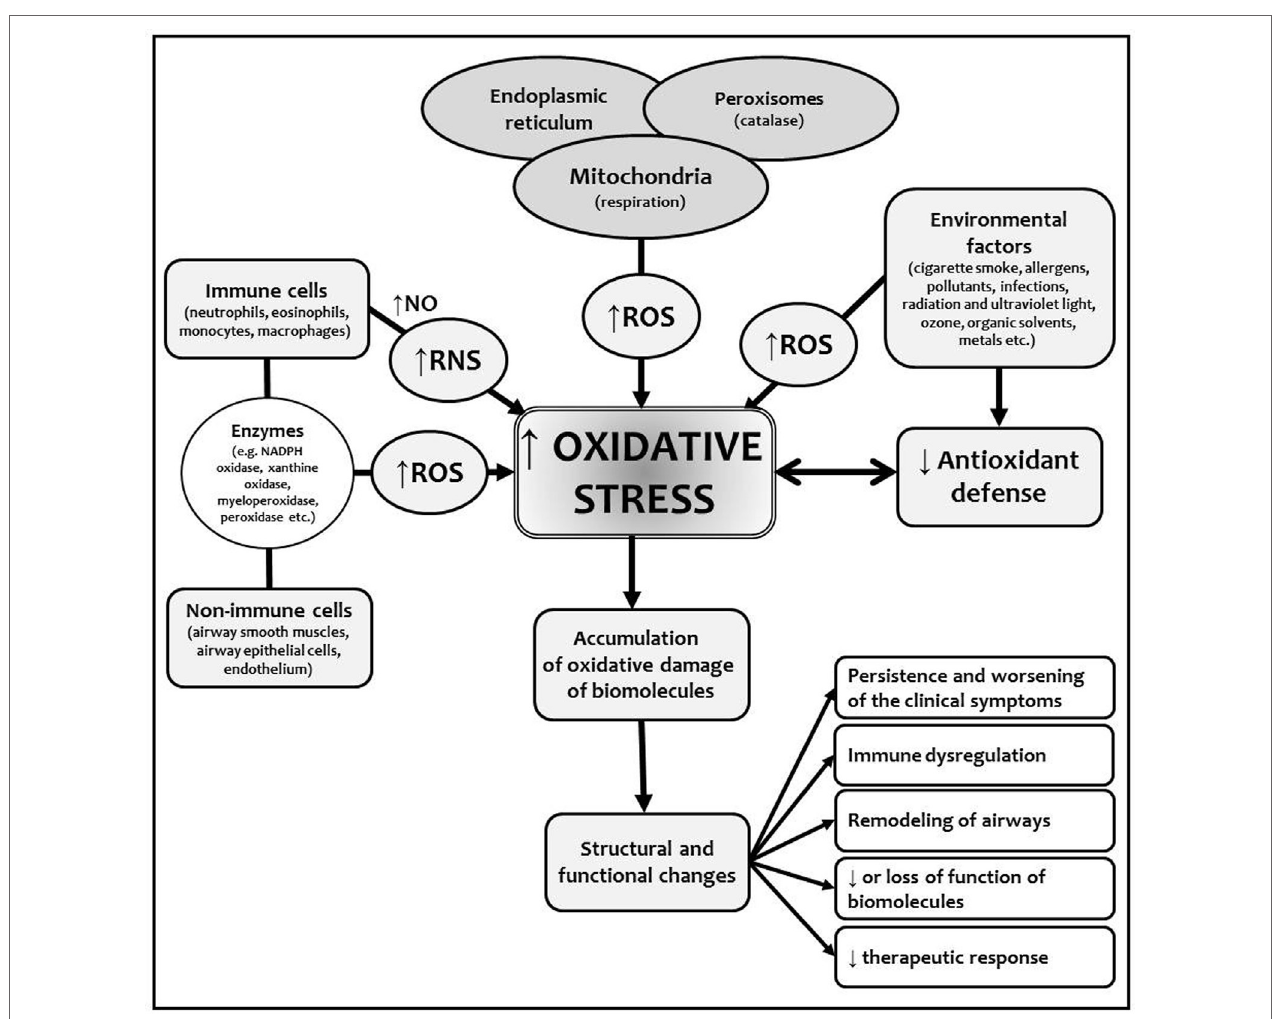
FigURe 1 | Origin of ROS and RNS and oxidative stress in bronchial asthma (BA). Chronic inflammation in BA is characterized by the overproduction of ROS/RNS as a consequence of increased activation of immune and non-immune cells in cellular inflammatory infiltrate. Various exogenous factors promote and amplify the inflammation and also increased the formation of reactive species via many mechanisms (e.g., induction of mitochondrial dysfunction, DNA repair mechanisms damage). Chronic inflammation decreases the capacity of endogenous antioxidant defense mechanisms, which are not able to compensate overproduction of ROS/RNS. This leads to the accumulation of the changes in biomolecules with structural and functional consequences. Abbreviations: NO, nitric oxide; RNS, reactive nitrogen species; ROS, reactive oxygen